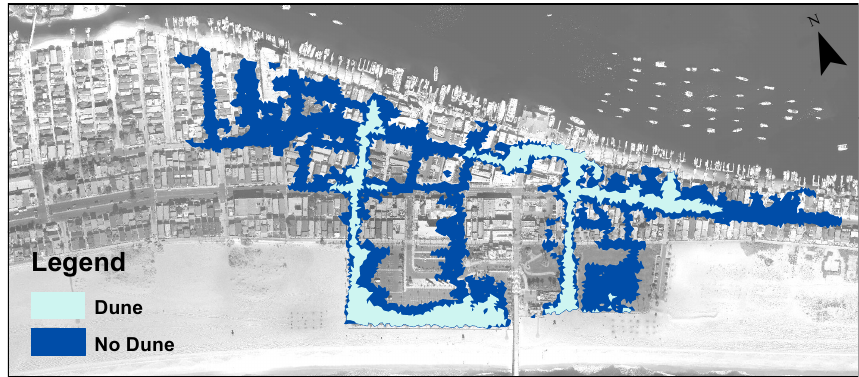
Figure 4. Overtopping flood extent with (light blue) and without (blue) an artificial dune. Predicted flooded area is 0.021 km 2 and 0.082 km 2 ,